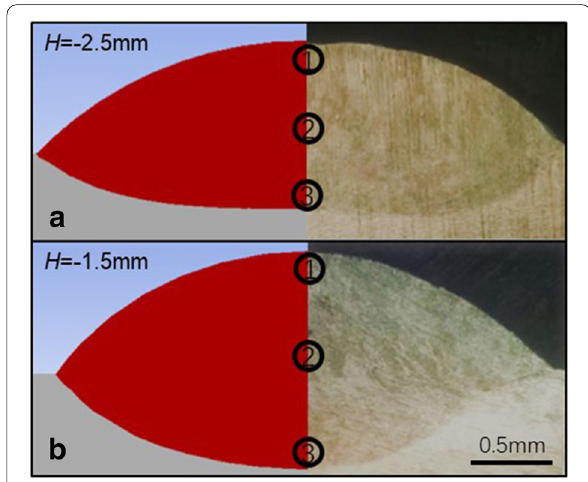
Figure 18 Comparison of cross-sections of deposited material between numerical simulation and experimental results at a H 2.5 mm and b H 1.5 mm = − = −